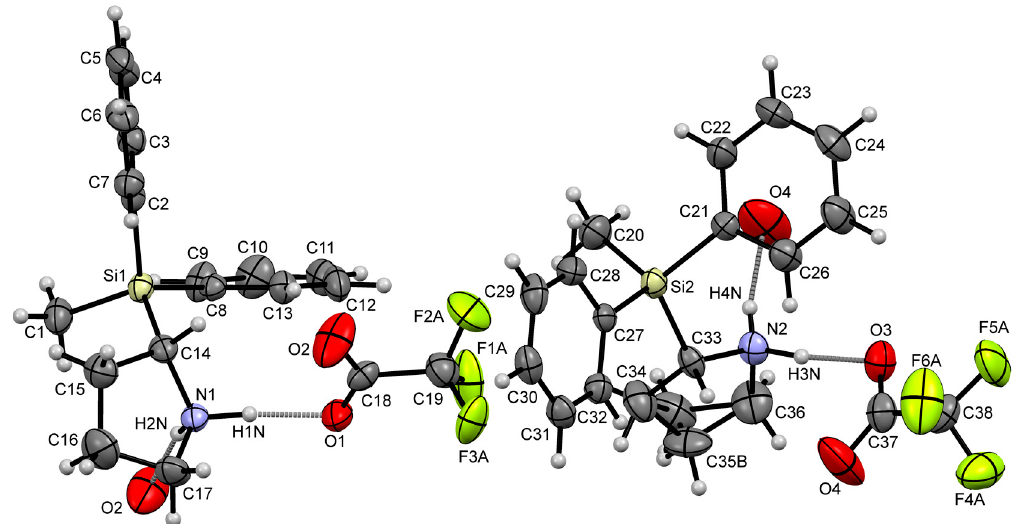
Figure 5. Part of the crystal structure (ORTEP plot) of compound ( S )- 2 ·TFA in the crystal, with the displacement ellipsoids set at the 50% probability level. The ellipsoids F(1B), F(2B), and F(3B) of the molecule ( S )- 2 ·TFA- A , and the ellipsoids F(4B), F(5B), and F(6B) of ( S )- 2 ·TFA- B are omitted for clarity. Selected bond lengths (Å) and angles (°): Molecule ( S )- 2 ·TFA- A : C(1)–Si(1) 1.849(2), C(2)–Si(1)